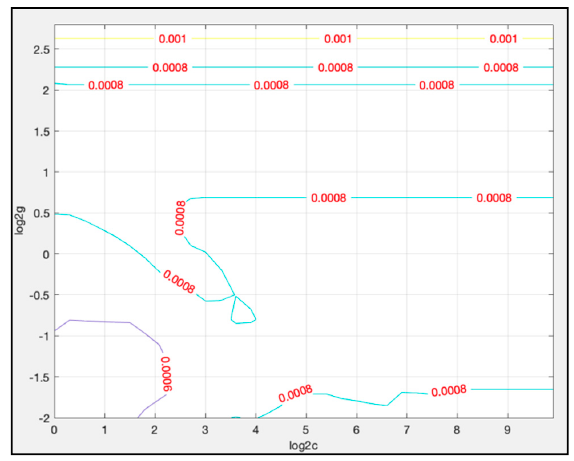
Figure 10. Result of fine selection.